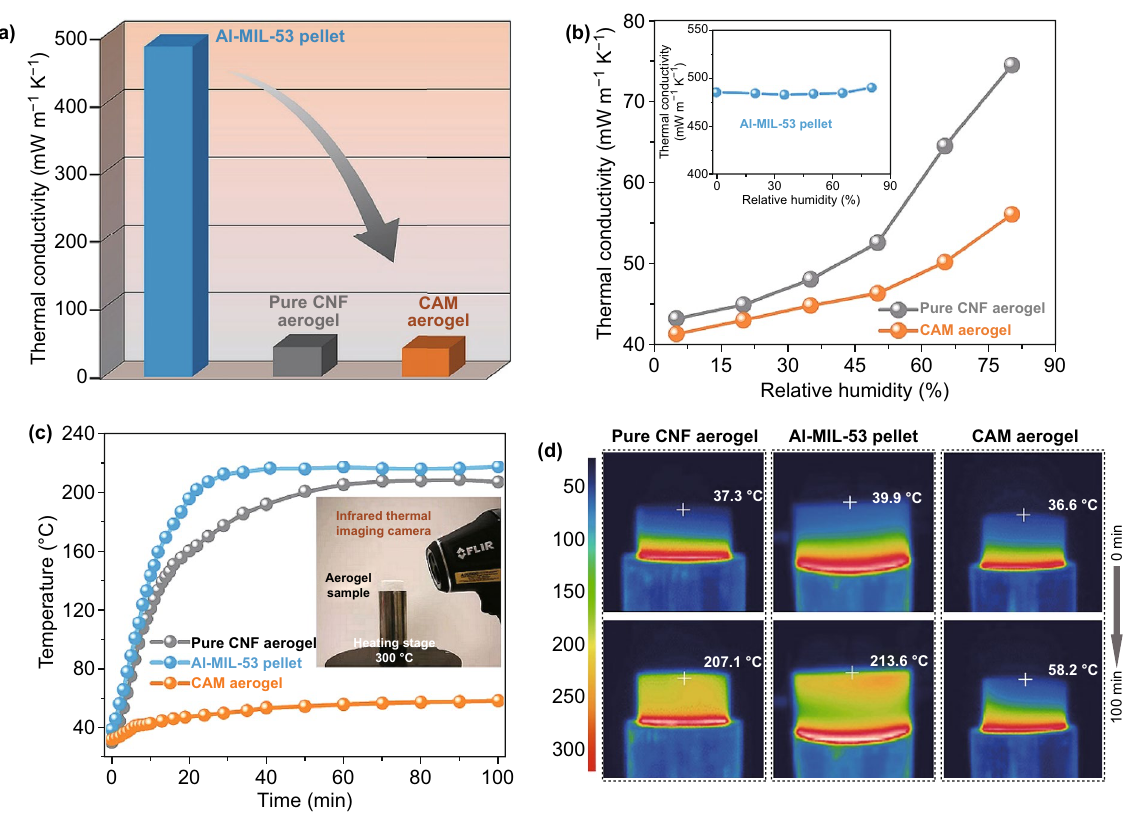
Fig. 3 a Thermal conductivity of the pure cellulose nanofiber (CNF) aerogel, the pure Al‑MIL‑53 pellet, and the CNF@Al‑MIL‑53 (CAM) aerogel at 5% relative humidity and room temperature. b Thermal conductivity of the pure CNF aerogel, the pure Al‑MIL‑53 pellet, and the CAM aerogel as a function of relative humidity at room temperature. c Time‑dependent temperature profile of the top surface of the pure CNF aerogel, the pure Al‑MIL‑53 pellet, and the CAM aerogel after placing on a 300 °C heating stage. The inset shows a photograph of the measure‑ ment apparatus. d Infrared side‑view images of the pure CNF aerogel, the pure Al‑MIL‑53 pellet, and the CAM aerogel, with the temperature of the top